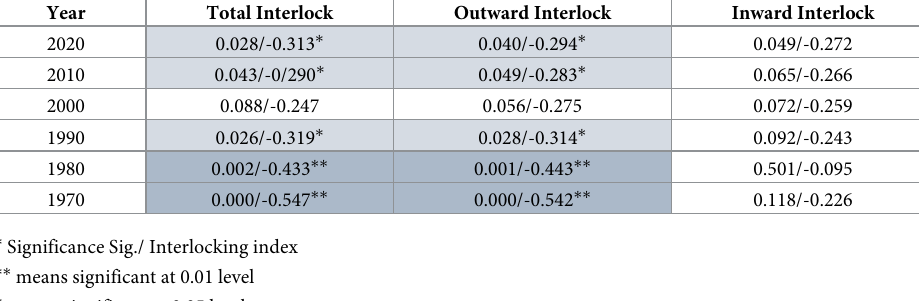
Table 4. The relationship between the distance to Milan and three interlock